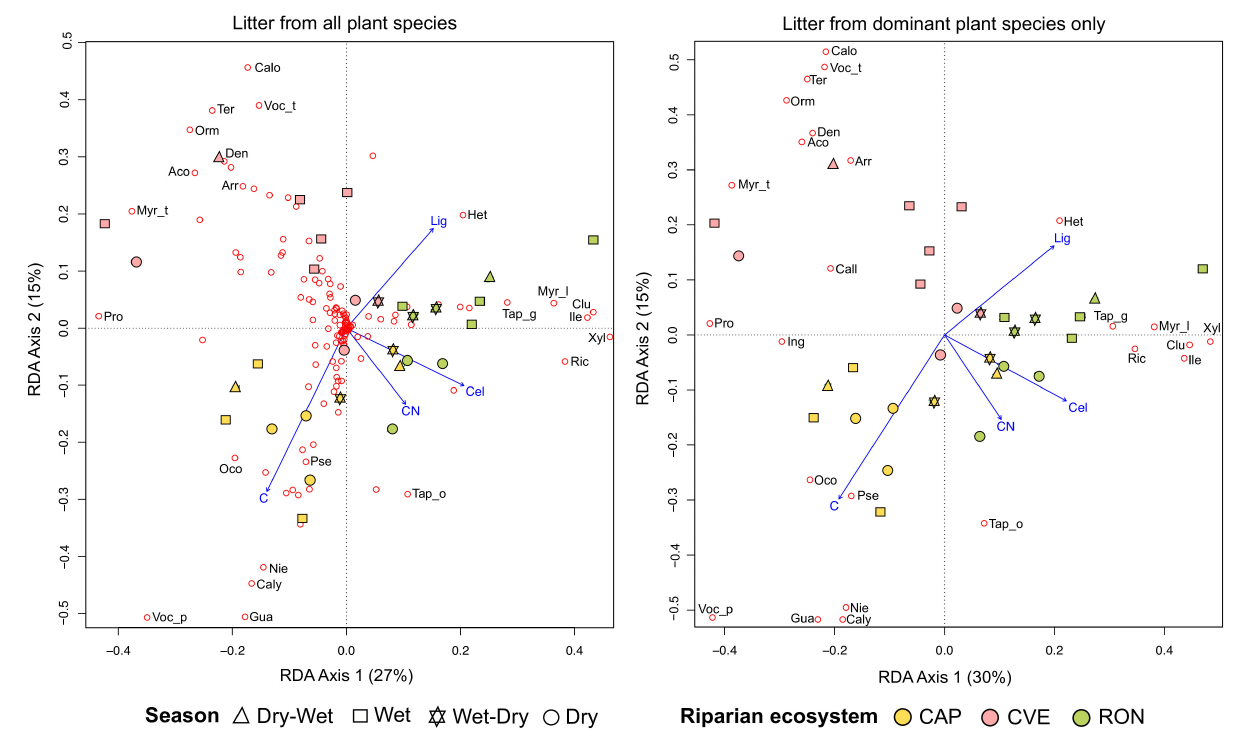
FIGURE 5 | Biplot ordinations of redundancy analyses (RDA) exploring the congruence between plant species composition of litterfall and litter chemical traits. Four non-colinear traits summarizing the chemical variation of litter were used in both RDA analyses (i.e., carbon, C:N, cellulose and lignin). Species data are shown with non-filled red circles. Species acronyms are shown only for the dominant species. Acronyms are the three initial letters of each species (or four letters if a genus represent more than one species) described in Figure 4